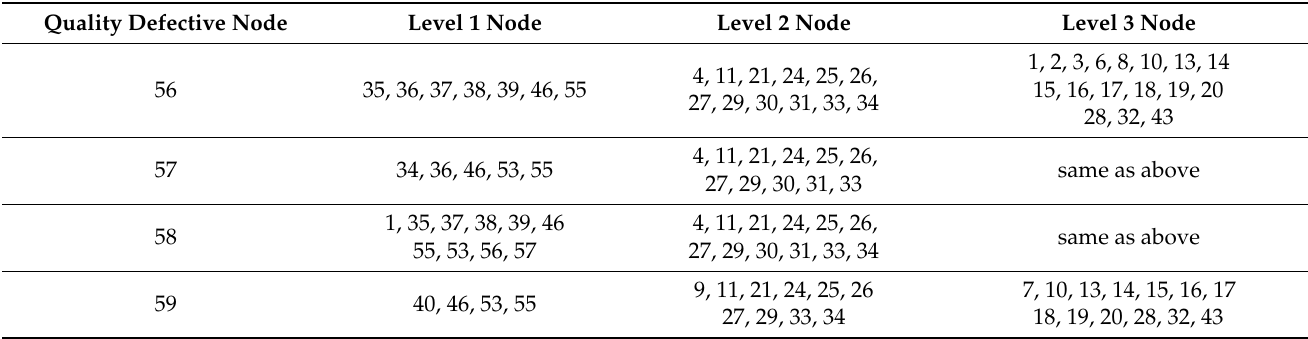
Table 10. Level 1–3 nodes of quality defective